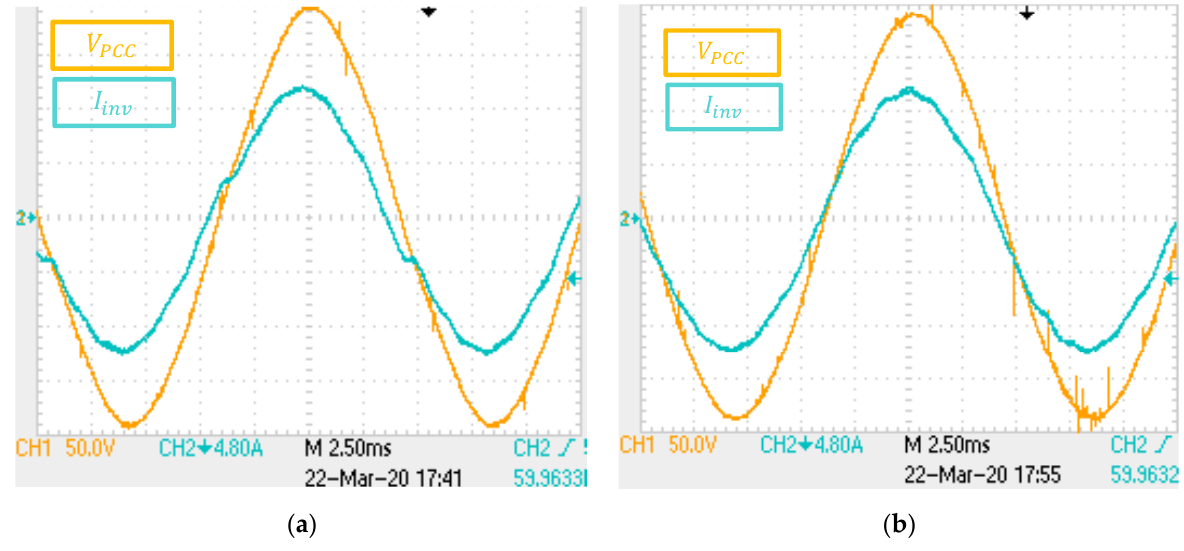
Figure 19. Inverter current ( a ) under AFD implementation; ( b ) under AFD by [24] implementation.